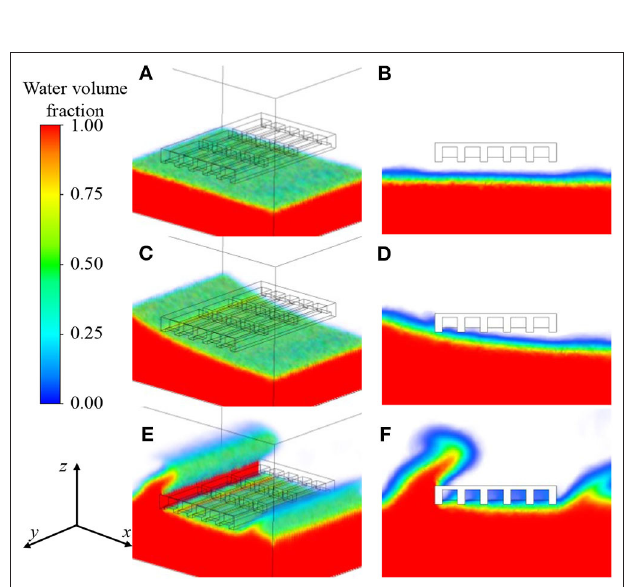
FIGURE 3 | An illustrative diagram of the wave-air-structure interaction effects in the three-dimensional CFD model. (A,C,E) Show the wave-air-deck interaction at three different chronological stages when the wave acts upon the deck; (B,D,F) indicate the associated wave profiles,